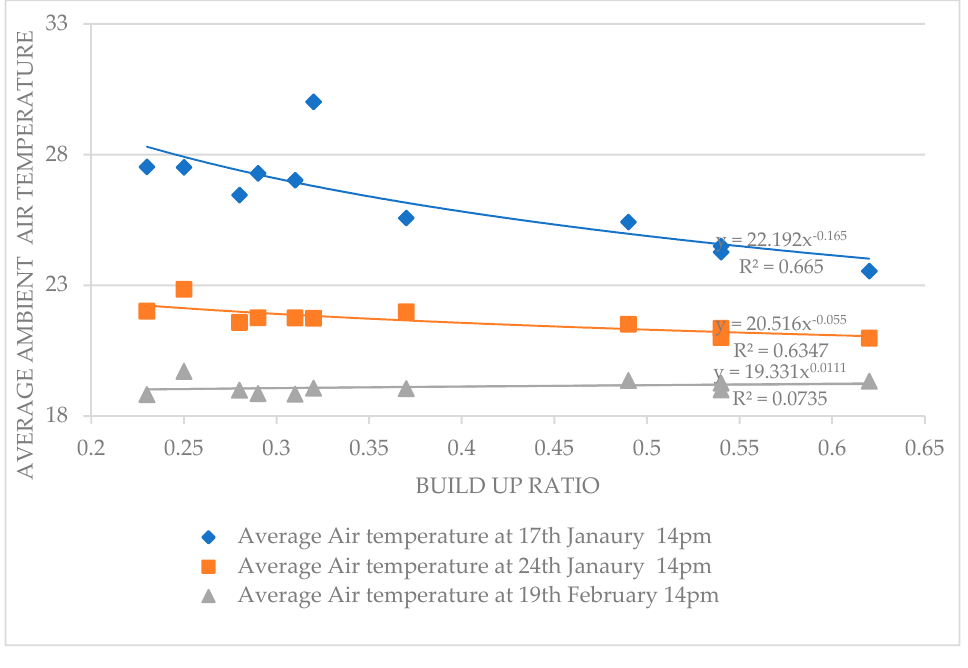
Figure 11. Comparison of the average ambient temperature and built-up ratio on three summer days. 17 January in blue, 24 January in red, 19 February in grey. Table 17. Average Air temperature on 17 (A), 24 January (B), and 19 February (C) at 2 p.m. and built-up ratio in all